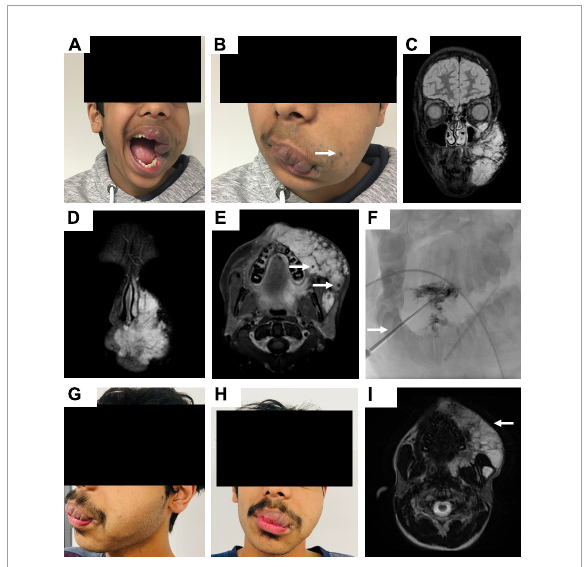
FIGURE1 Fourteen-year-old male patient with a venous malformation (VM) primarily affecting the nasal, buccal, mental, and labial area of the left face. (A,B) Clinical photographs demonstrate the appearance of the patient with extensive swelling in the areas affected by the VM and enormous labial deformation on the left side. Superficial bluish discoloration of the skin is marked by an arrow. (C–E) Coronar and axial fat-saturated T2-weighted MR images present typical hyperintense signal of the facial VM with multiple hypointense spots representing phleboliths (arrows). (F) Periprocedural digital subtraction angiography (DSA) images while successful percutaneous sclerotherapy of oropharyngeal compartments, the arrow marks the oral inserted angiocatheter. (G,H) Clinical photographs show the appearance of the patient 3 years post sclerotherapy with reduced swelling of the affected areas. The patients’ lip closure can be performed completely